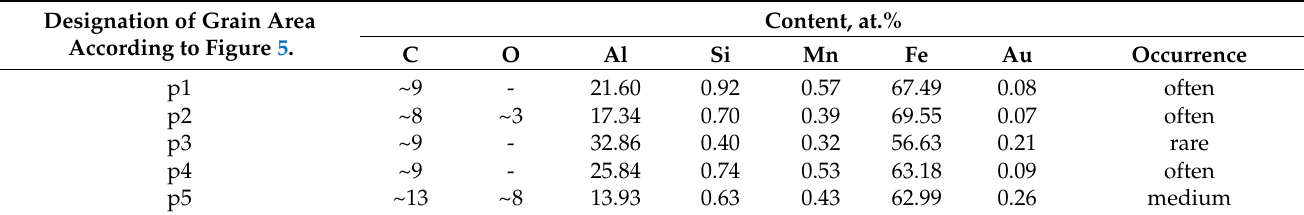
According to Figure